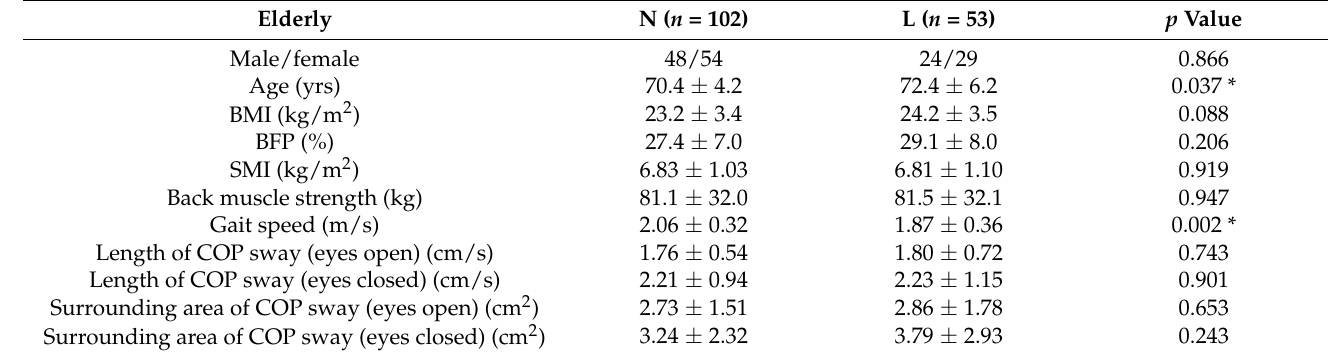
Table 4. Comparison of each parameter between the N and L groups in elderly participants.